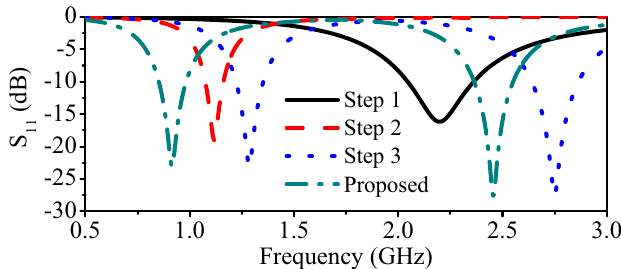
Figure 9. Reflection coefficients of the dual-band implantable antenna in design iterations.